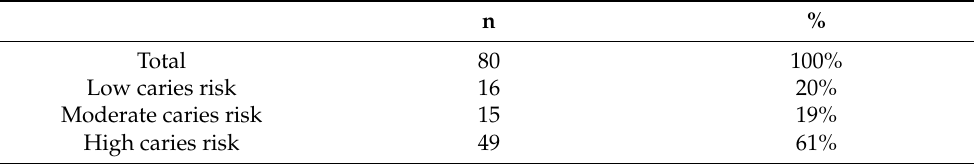
Table 4. Distribution by caries risk evaluation.